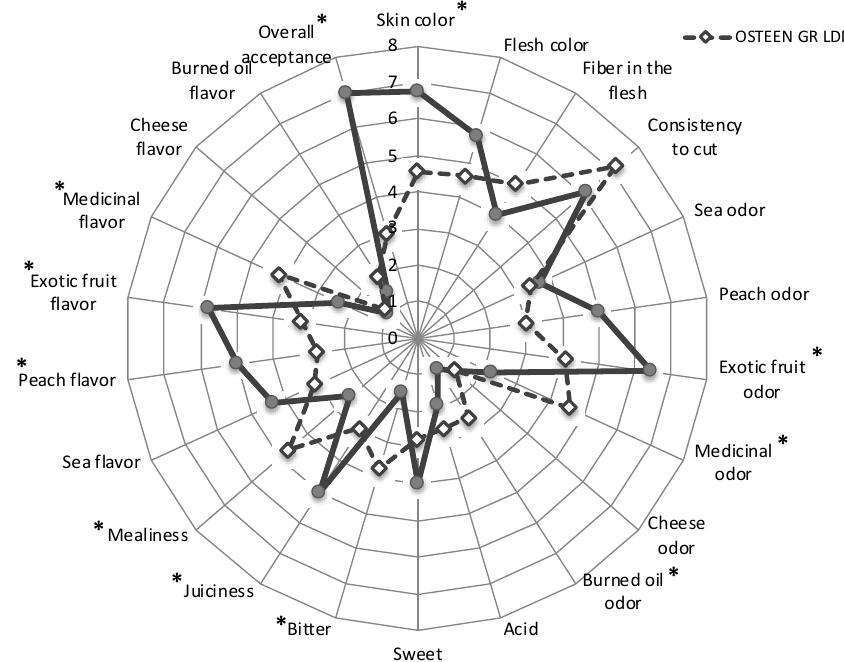
Figure 5. Sensory analysis of mature-green (GR) fresh Mediterranean Italian (MedIT) and imported (LDM) “Osteen” mango fruit. Data are Mean of 15 fruit for each ripening stage. * Indicates significant differences for values (Tukey’s test at p ≤ 0.05).